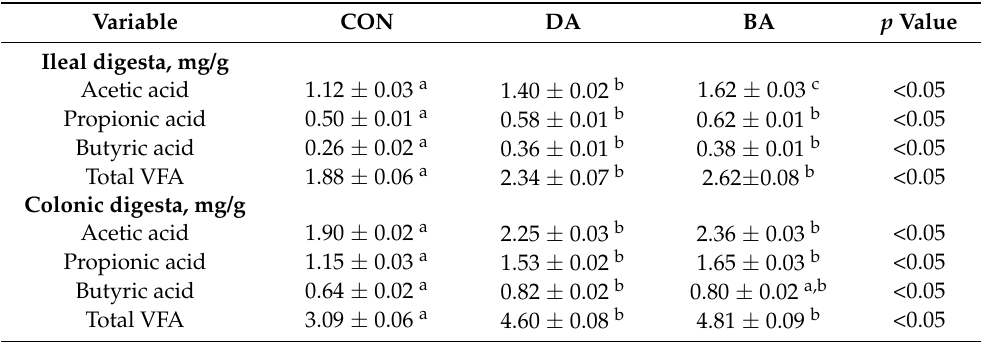
Table 2. Effects of dietary sodium caprylate on volatile fatty acids (VFAs) concentration in intestinal contents of C57/BL6 mice (Exp. 2)